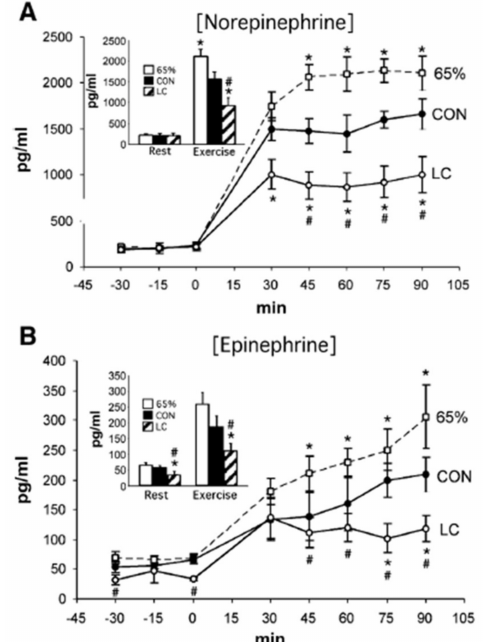
Figure 9. Plasma norepinephrine ( A ) and epinephrine ( B ) concentrations across time during rest and exercise. Shown are data for control (CON) and lactate clamp (LC) at 55% VO 2 peak; 65% indicates 65% VO 2 peak. Insets are mean rest and exercise for each condition. p < 0.05 is significantly di ff erent from CON (*) and significantly di ff erent from 65% ( # ). Results show a suppression of plasma catecholamine levels by exogenous lactate. See text for discussion. From